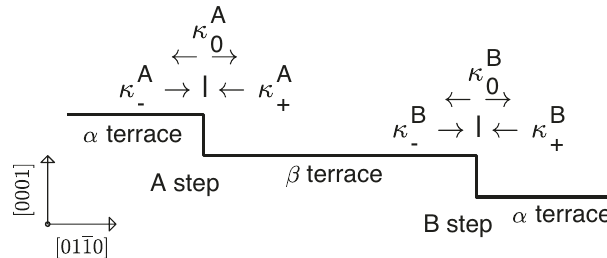
Fig. 7 Schematic of alternating terraces and steps for the BCF model. Vicinal {0001} surfaces of HCP crystals have alternating α and β terraces separated by A and B steps. Notations are indicated for the kinetic coef fi cients for adatom attachment from below and above and for adatom transmission. Schematic of alternating terraces and steps of BCF model for HCP basal-plane surfaces, showing kinetic coef fi cients for the A and B steps.